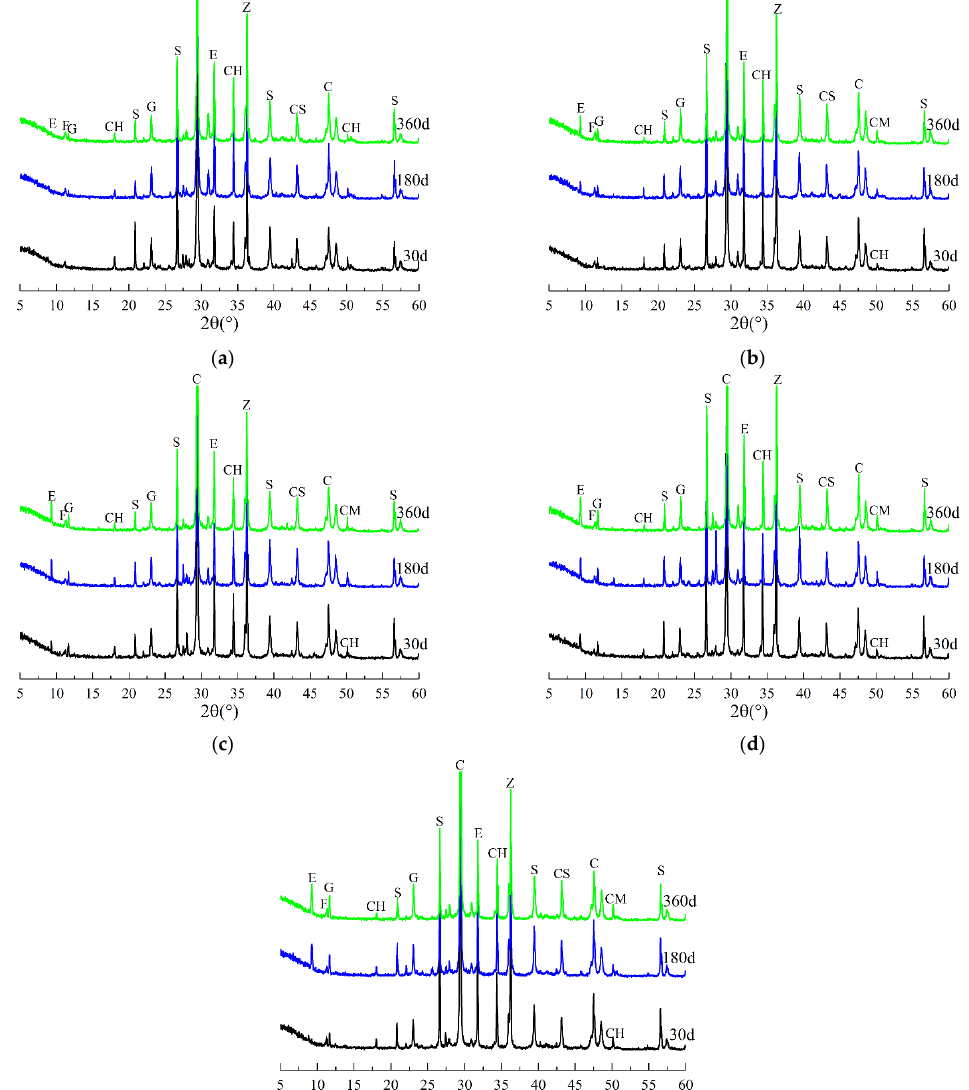
Figure 7. Mineral analysis after erosion: ( a ) C; ( b ) CS0.2-M; ( c ) CS0.5-M; ( d ) CS0.7-M; ( e ) CS1-M. E—AFt; G—gypsum; F—Friedel's salt; CH—Ca(OH) 2 ; S—SiO 2 ; C—CaCO 3 ; CS—C 3 S/C 2 S; Z—ZnO; CM—Mg(OH) 2 .